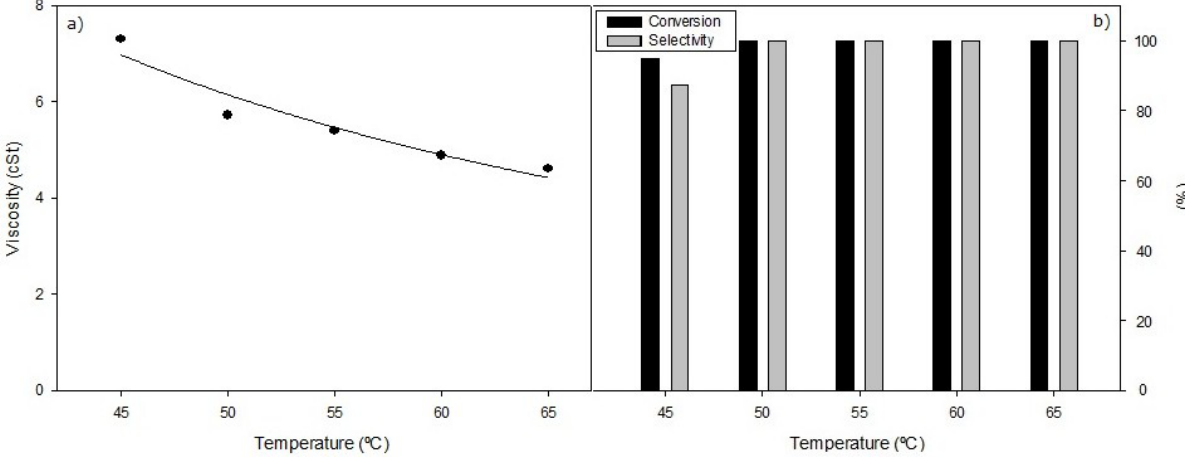
Figure 4. ( a ) Viscosity values and ( b ) Conversion and Selectivity values, obtained in the heterogeneous selective methanolysis of sunflower oil carried out under standard conditions, reaction time 60 min, 0.8 g of KF/Al methanol, under different reaction temperatures in the interval 45–65 °C.